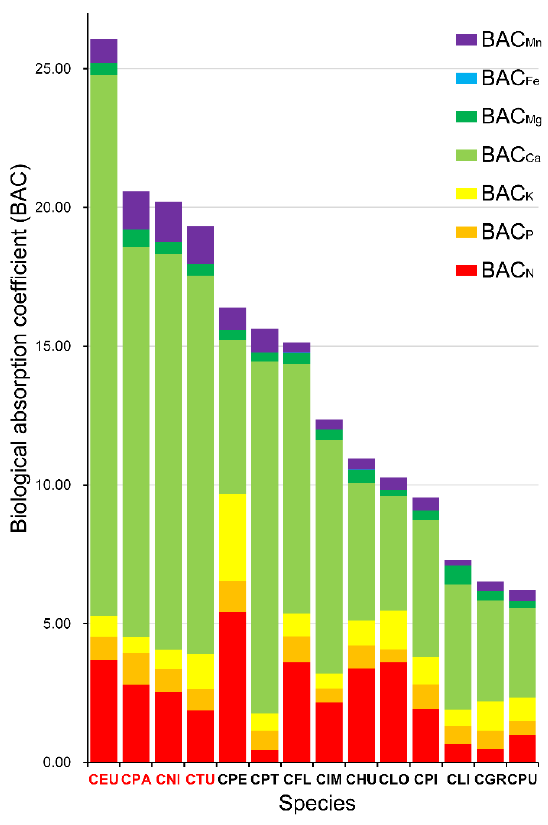
Figure 2. Biological absorption coefficient of each nutrient in golden Camellia species. The right sub ‐ scripts of BAC in the legend represent the different elements. The black and red species labels represent CSC and ASC, respectively.